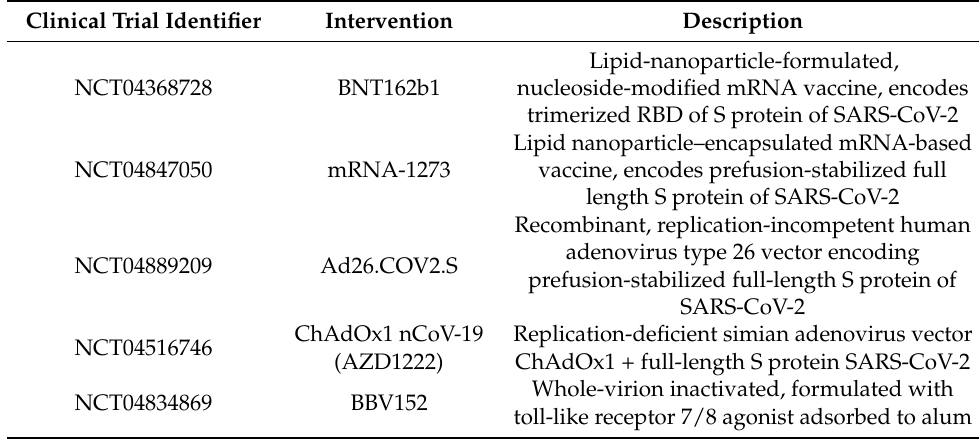
Table 1. Clinical trials of RNA-based and other vaccines against